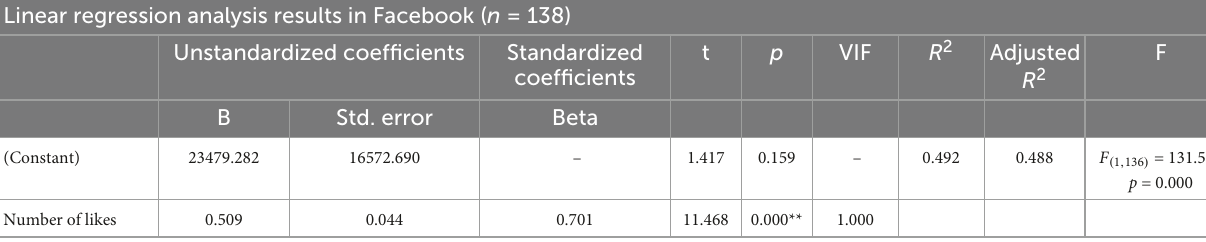
TABLE 3 Linear regression analysis of the effect of Facebook likes on number of followers. Linear regression analysis results in Facebook ( n = 138)